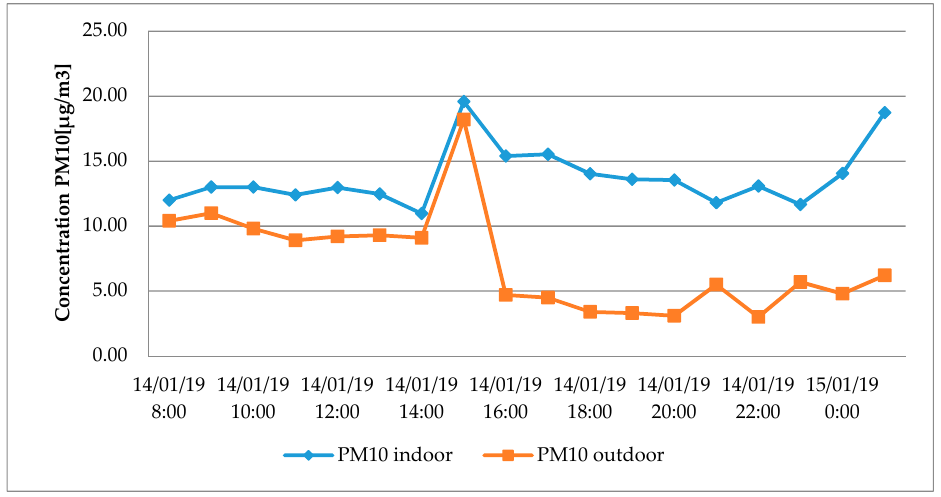
Figure 1. Concentration of PM10 (µg/m 3 ) in an apartment in multifamily building (PM10 indoor) and in outdoor air.